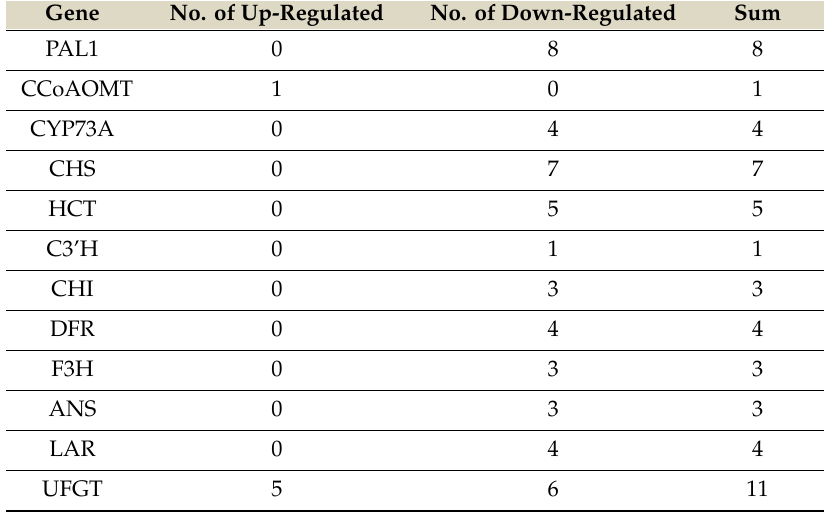
Table 5. Di ff erential expression genes related to anthocyanins metabolism under TA treatment. Gene No. of Up-Regulated No. of Down-Regulated